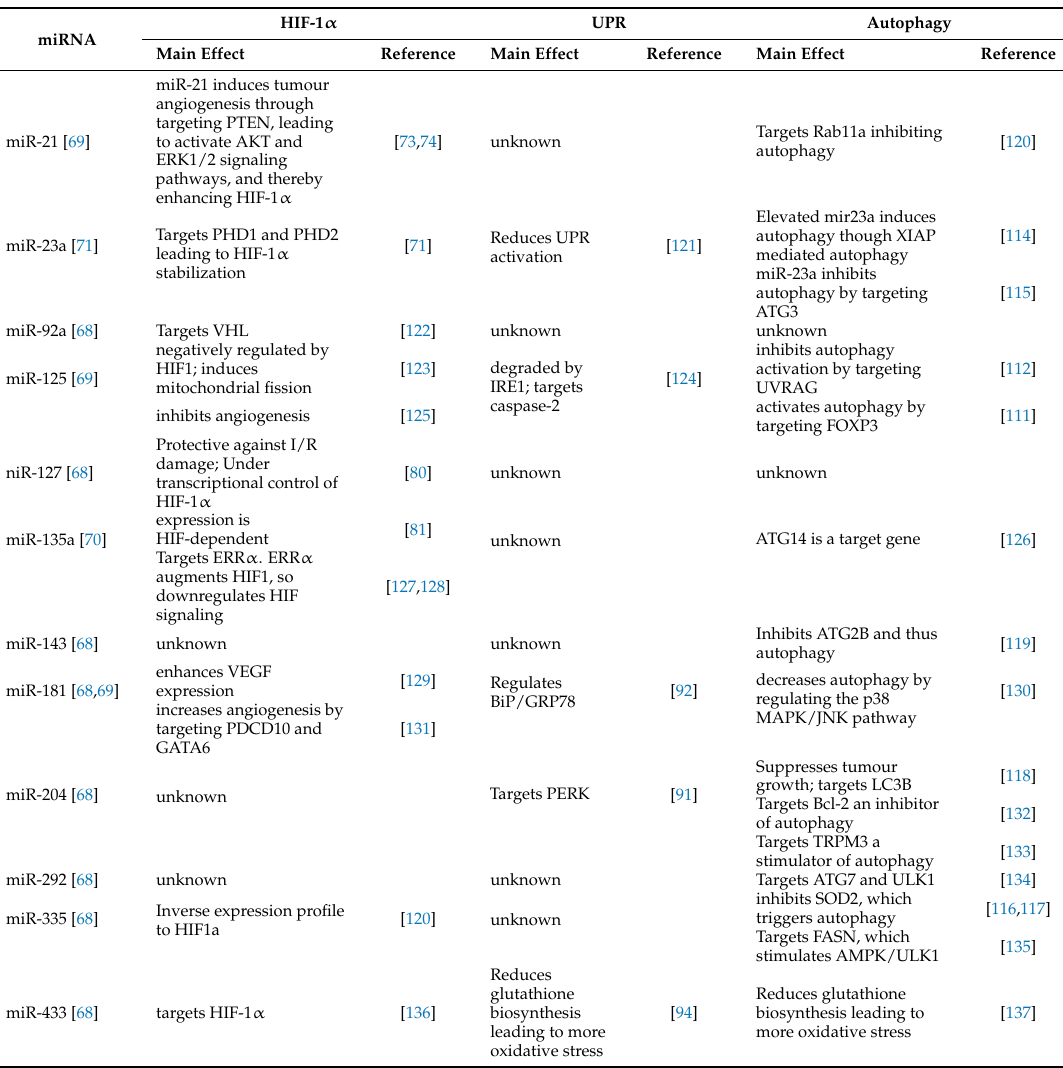
Table 1. Summary of miRNAs found to be upregulated in EV from hypoxic tumours and their possible effects on HIF-1 α , UPR and